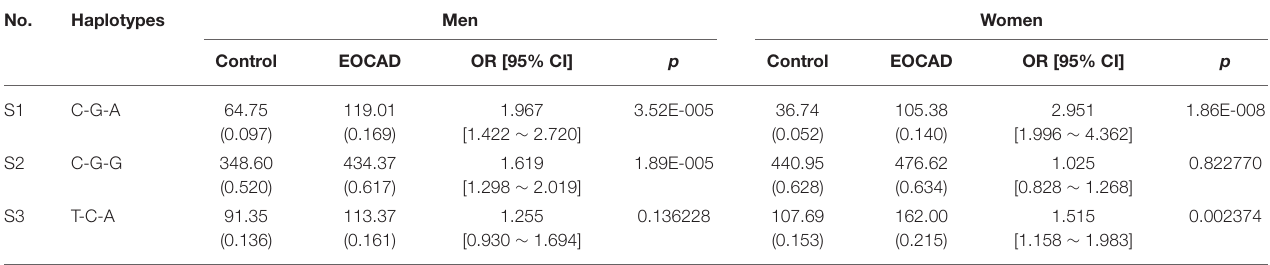
TABLE 6 | Haplotype frequencies and the associations between haplotypes and the risk of EOCAD in men and women populations. No. Haplotypes Men